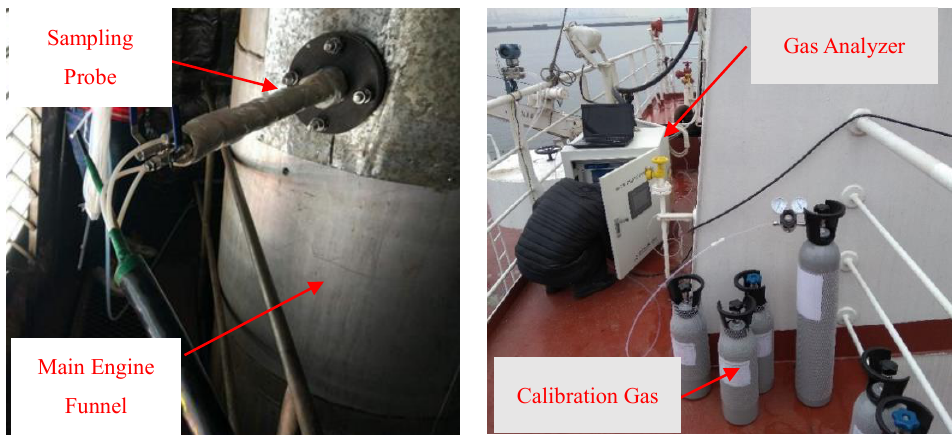
Figure 2. The sampling probe in the funnel of the main engine and calibration of the instruments.